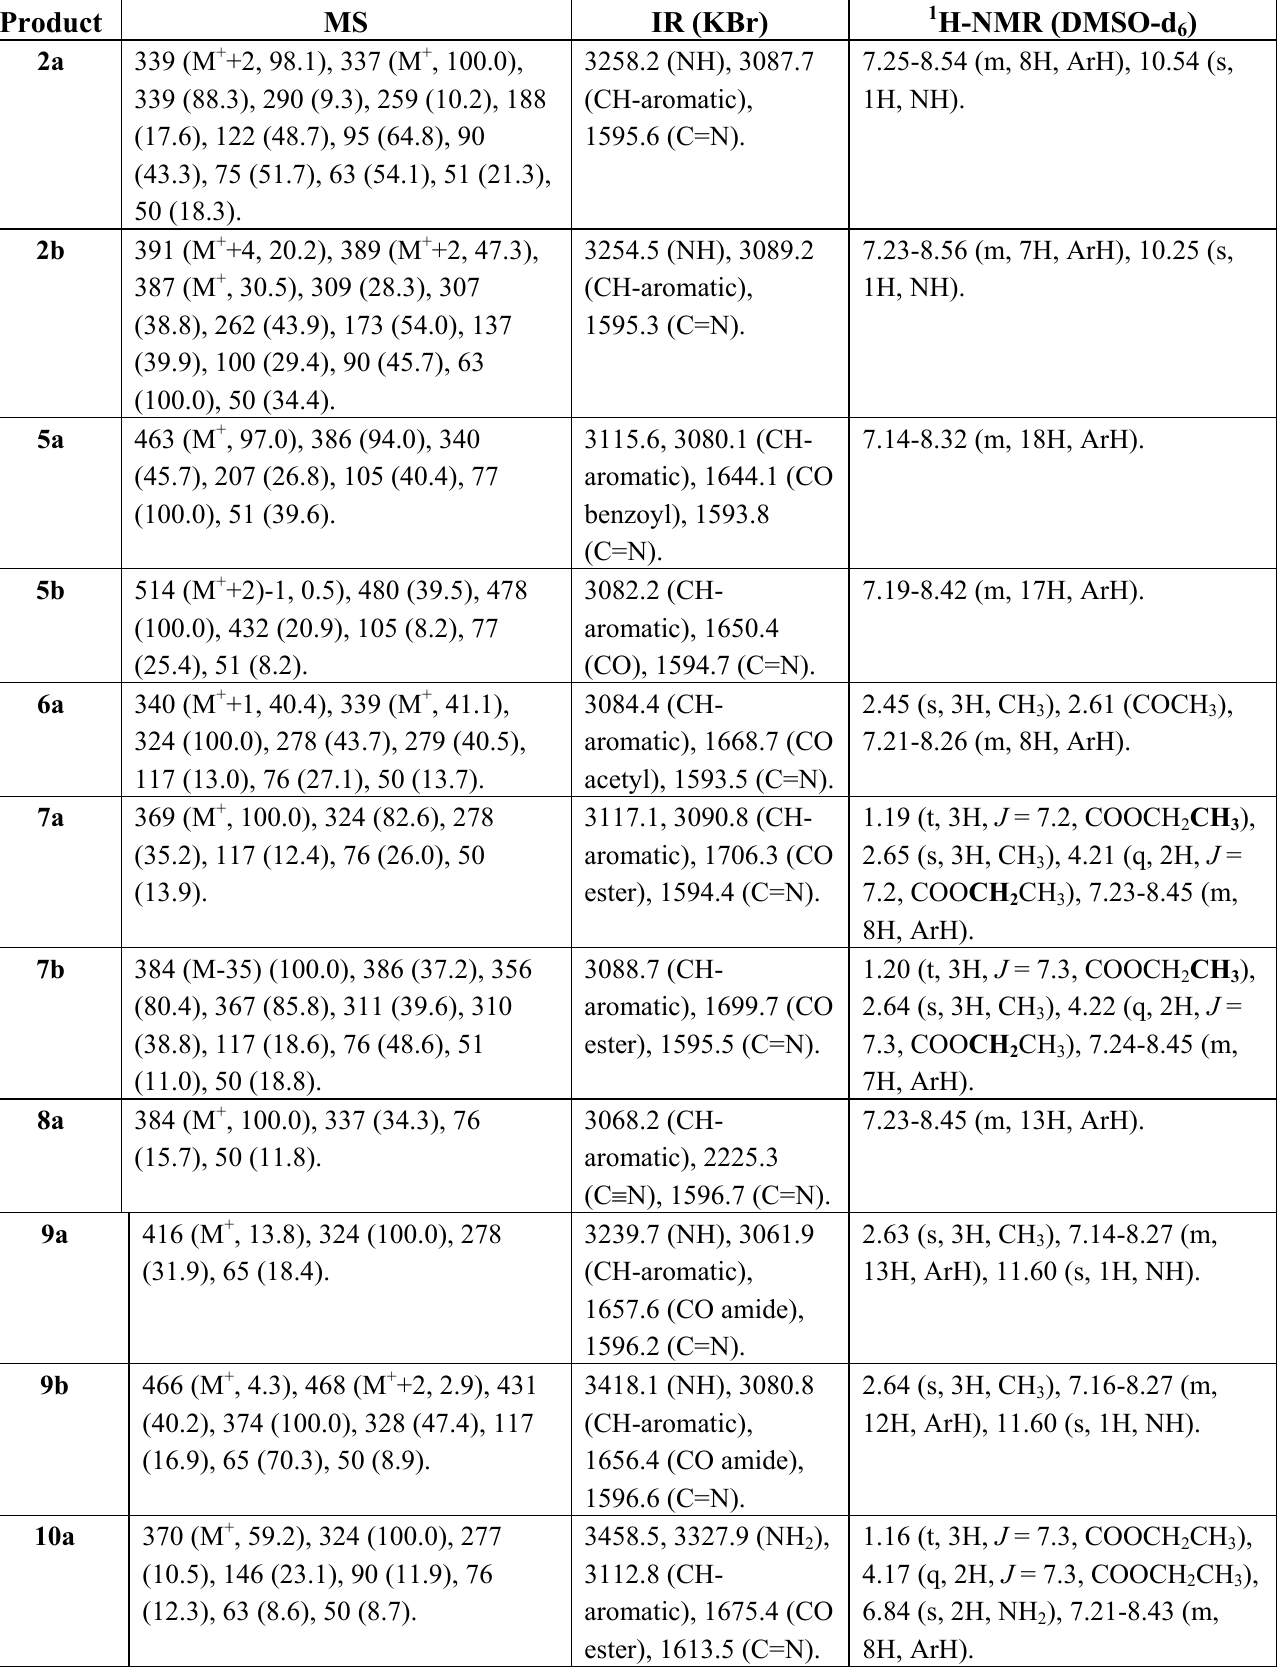
Table 3. Spectroscopic data of the newly prepared